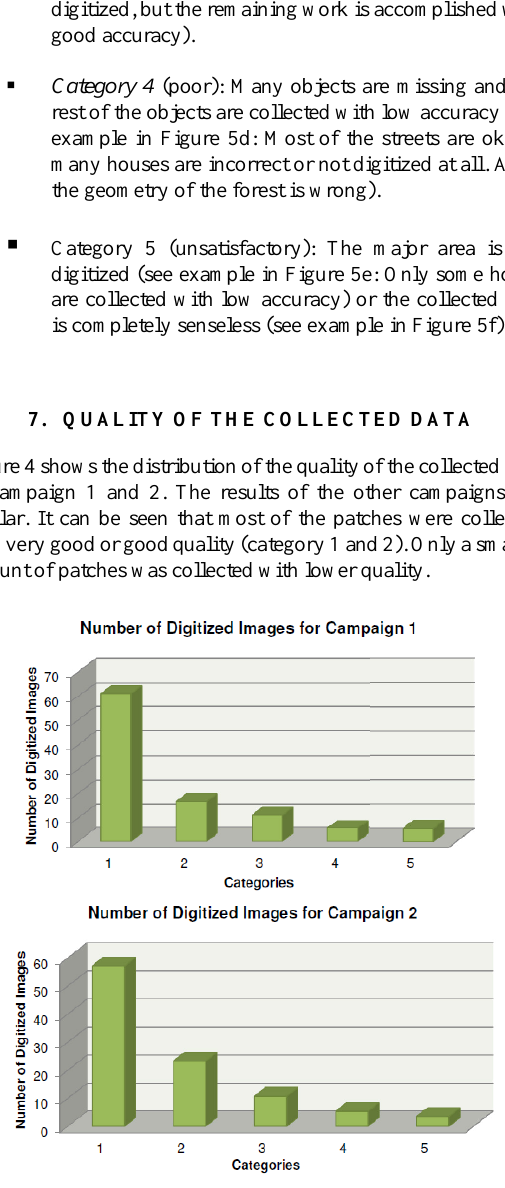
Figure 4. Quality of the collected